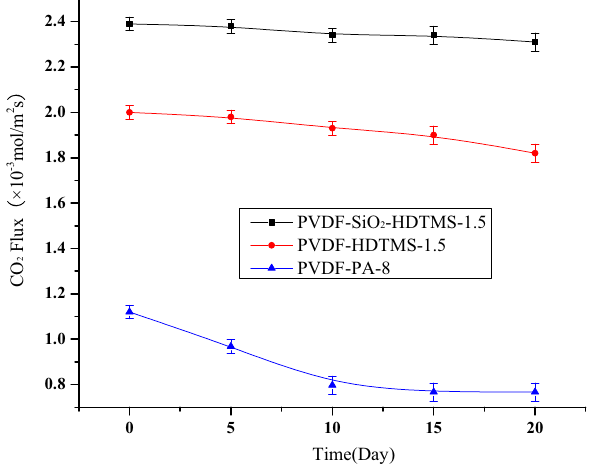
Figure 5. Long-term CO 2 absorption performance of the membranes (The data of Long-term CO2 absorption performance of the membranes can be viewed in Supplementary material 2).